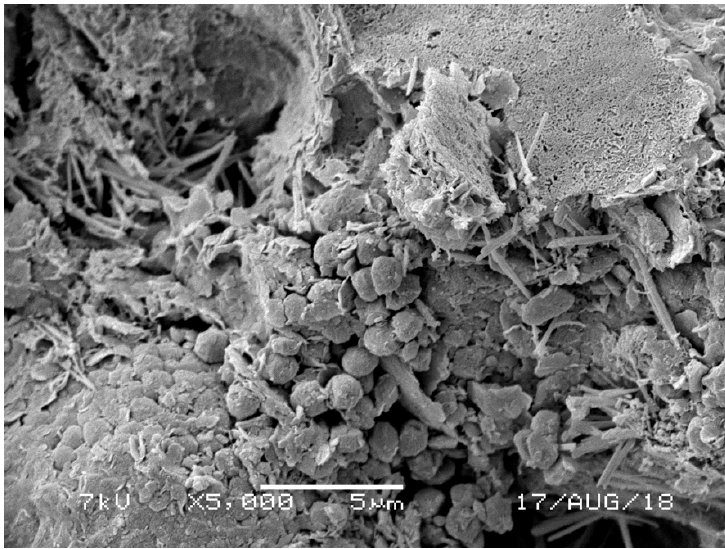
Figure 15. SEM of clay-cement–ash sample.